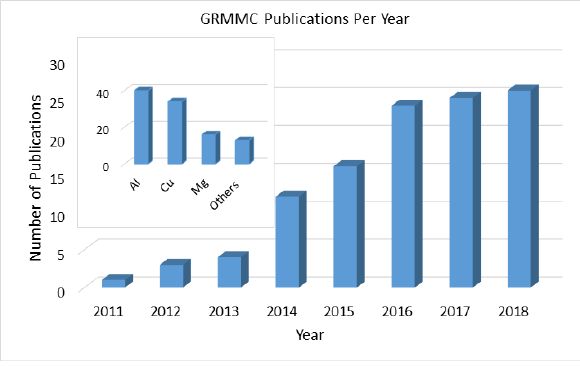
Figure 1: Number of publications on bulk GRMMCs per year based on Web of Science and Science Direct databases. The index shows the number of publications per metal